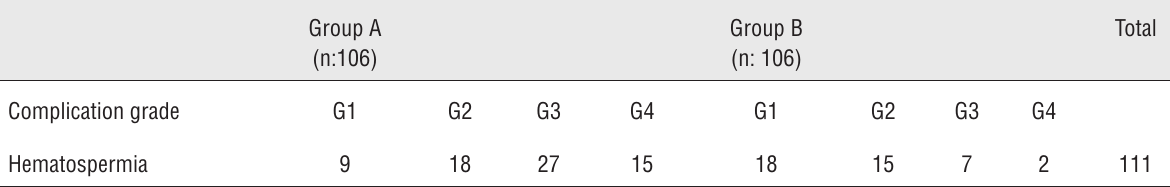
Table 2 - Incidence of complications among the two groups.